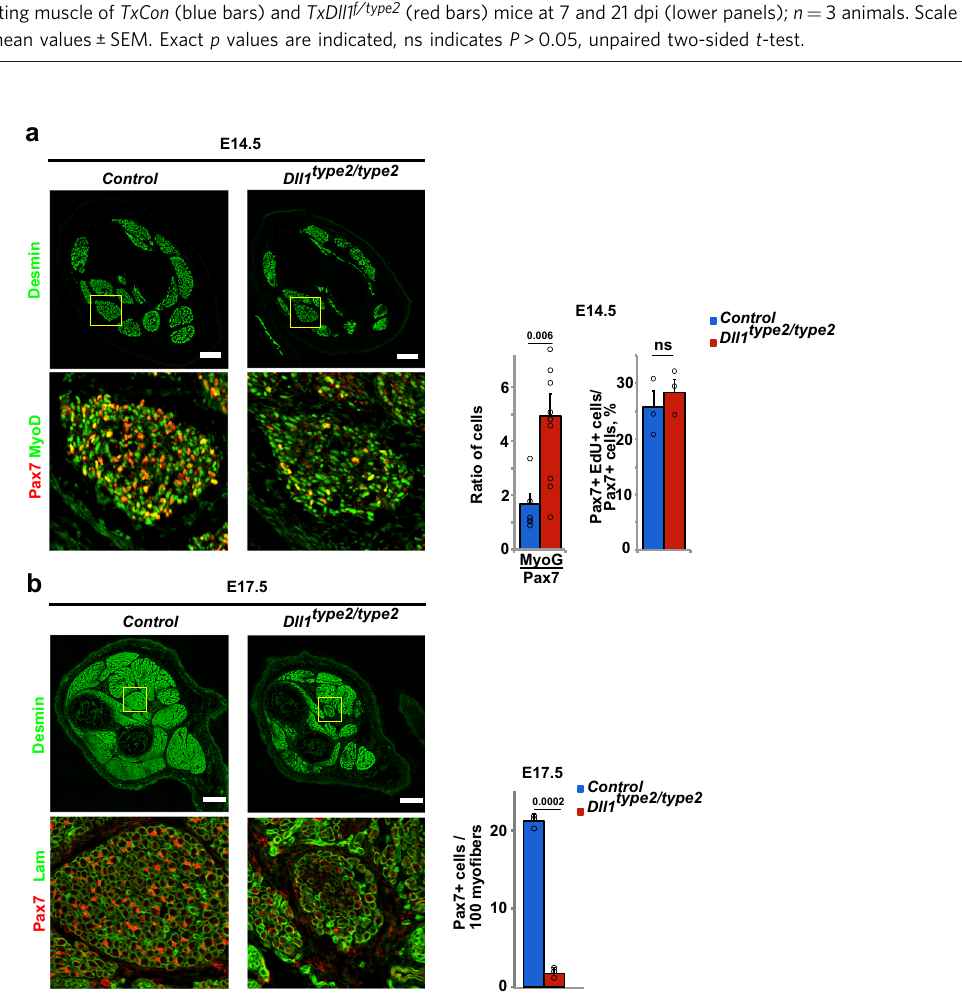
Fig. 7 Oscillatory Dll1 expression controls muscle regeneration. a Quanti fi cation of the number of cells in colonies formed on myo fi bers; myo fi bers were isolated from TxCon (blue bars) and TxDll1 f/type2 mice (red bars) and cultured for 60 and 72 h; n = 3 animals. b Quanti fi cation of cells that express MyoG + only (green), MyoG + and Pax7 + (yellow), and Pax7 + only (red) in colonies associated with myo fi bers after 72 h of culture; fi bers were isolated from TxCon and TxDll1 f/type2 mice; n = 3 experiments. c Gating strategy and representative FACS plot used to de fi ne MyoG + (MyoG-cy3) and Pax7 + (Pax7-cy5) cells in cultured spheres containing wild-type (WT) and Dll1 type2 mutant cells; n = 3 experiments. d Immunohistological analysis of the regenerating muscle of TxCon and TxDll1 f/type2 mutant mice at 4 dpi using anti-Pax7 (red) and anti-MyoG (green) antibodies; DAPI (blue) was used as counterstain (upper left). Quanti fi cations of the number of Pax7 + and MyoG + cells in TxCon (blue bars) and TxDll1 f/type2 (red bars) muscle, and relative proportion of MyoG + (green) and Pax7 + (red) cells in TxCon and TxDll1 f/type2 muscle (upper right); quanti fi cation of Hes1 expression levels in Pax7 + cells and variance of Hes1 protein levels in single and coupled Pax7 + cells of the regenerating muscle (4 dpi) of TxCon (blue bars) and TxDll1 f/type2 (red bars) animals (lower panels); n = 3 animals. e Immuno fl uorescence analysis of TxCon and TxDll1 f/type2 mutant mice at 7 and 21 dpi using anti-Pax7 (green) and anti-collagen IV (ColIV; blue) antibodies; DAPI (red) was used as counterstain (upper panels). Quanti fi cation of the number of Pax7 + cells, number of nuclei/ fi ber and fi ber diameter in the regenerating muscle of TxCon (blue bars) and TxDll1 f/type2 (red bars) mice at 7 and 21 dpi (lower panels); n = 3 animals. Scale bars, 50 μ m.